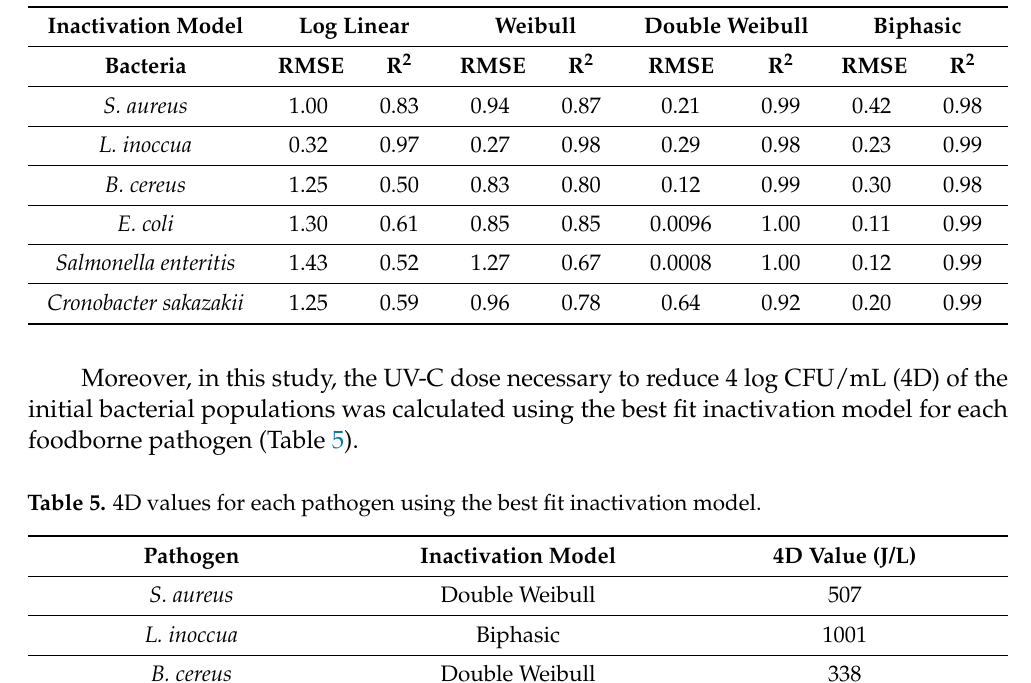
Table 4. Root mean square error (RMSE) and R2 measures for each pathogen using different inactiva- tion models.